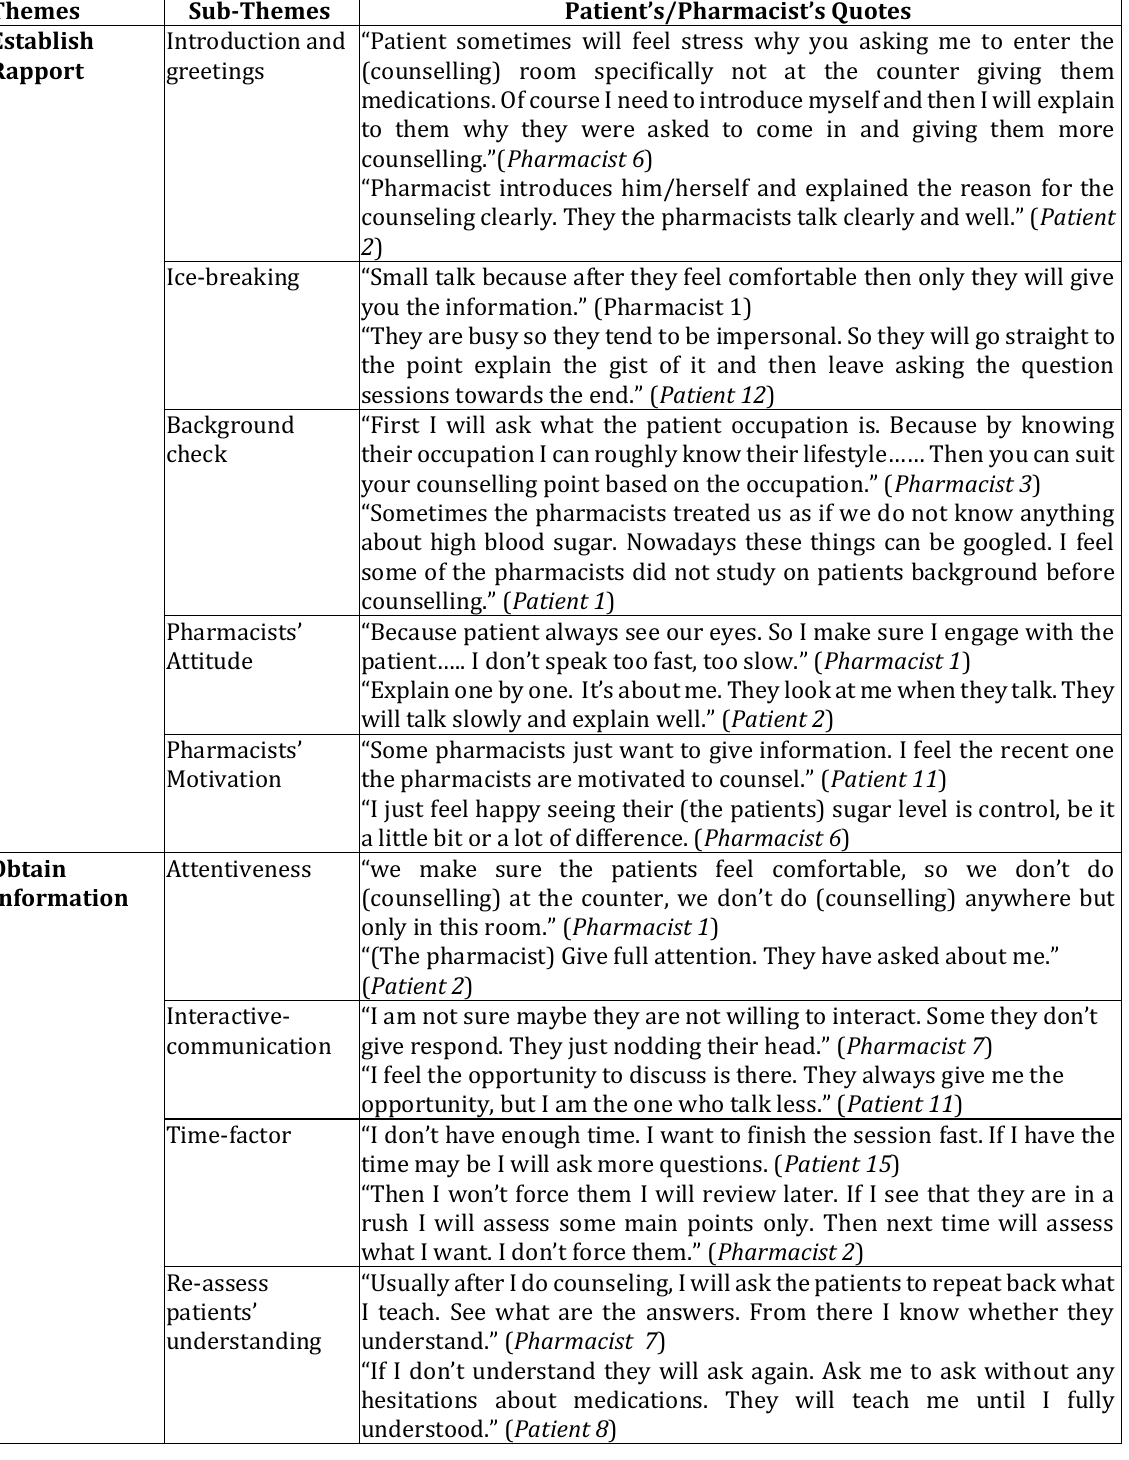
Table II. Themes, Sub-themes and Patient’s/Pharmacist’s Quotes